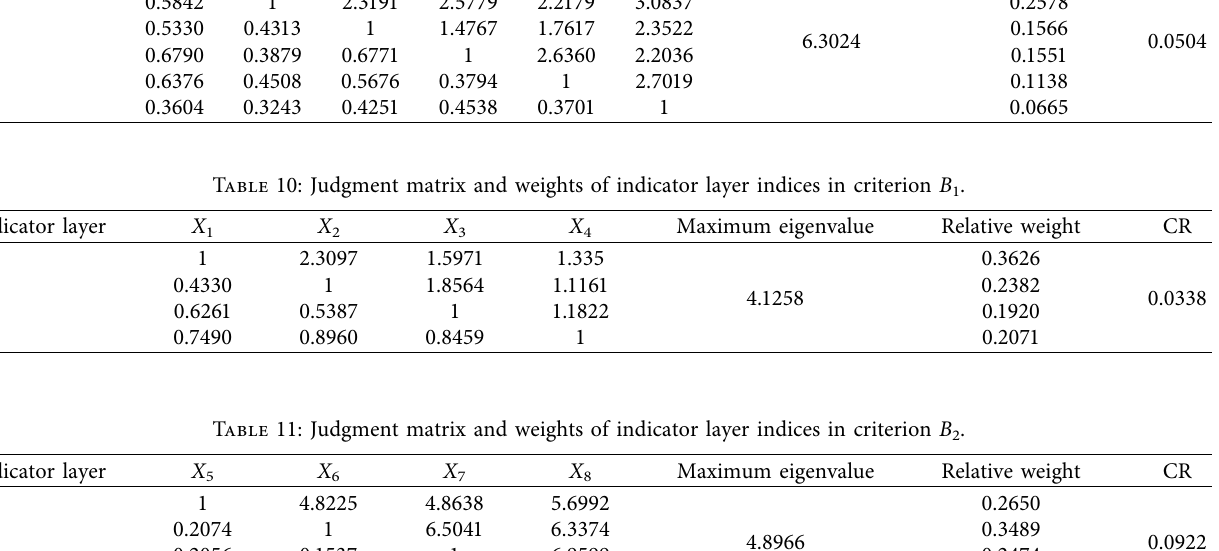
Table 9: Judgment matrix and weights of criterion layer indices.